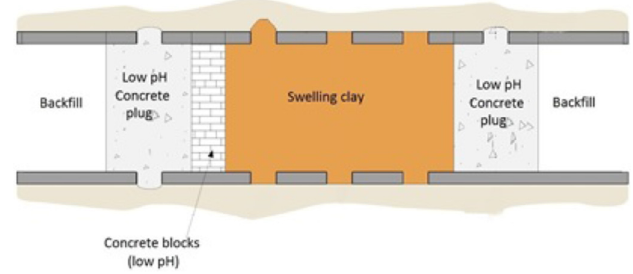
Fig. 1. Tunnel plug in the ANDRA concept.